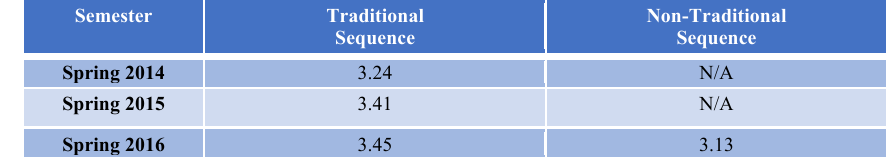
Table 3. Course Grade